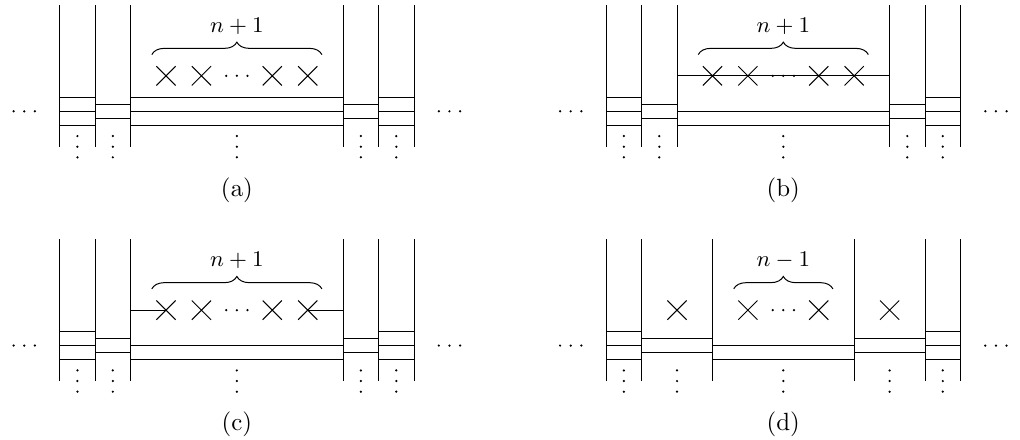
Figure 11. A n Kraft-Procesi transition. (a) Generic part of a Coulomb branch brane con(cid:12)guration with moduli space M C . The moduli space generated by a D3-brane in the middle interval is the variety S = A n , i.e. it is isomorphic to the Coulomb branch of 3 d N = 4 SQED with n + 1 (cid:13)avors. (b) The relevant D3-brane is at the singular point ~x = ~m i = (0 ; 0 ; 0). (c) The D3-brane is split into n + 2 segments, n of them can acquire nonzero ~y j position along the directions spanned by the D5- branes. Taking the limit when these positions go to in(cid:12)nity, e(cid:11)ectively removes these branes from the system. This gives rise to a new brane con(cid:12)guration with a new Coulomb branch M 0 (d) The (cid:12)xed three branes are annihilated via two phase transitions in order to obtain a Coulomb branch brane con(cid:12)guration where the corresponding new quiver can be